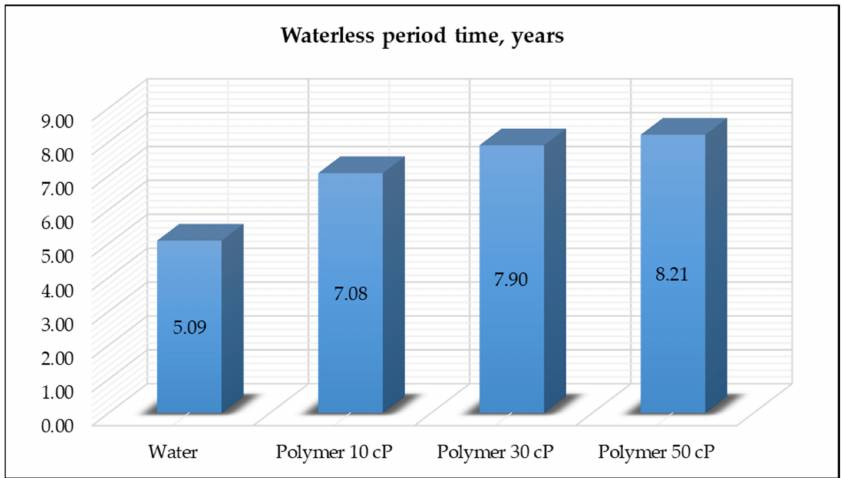
Figure 8. Time of water-free operation for various options of oil